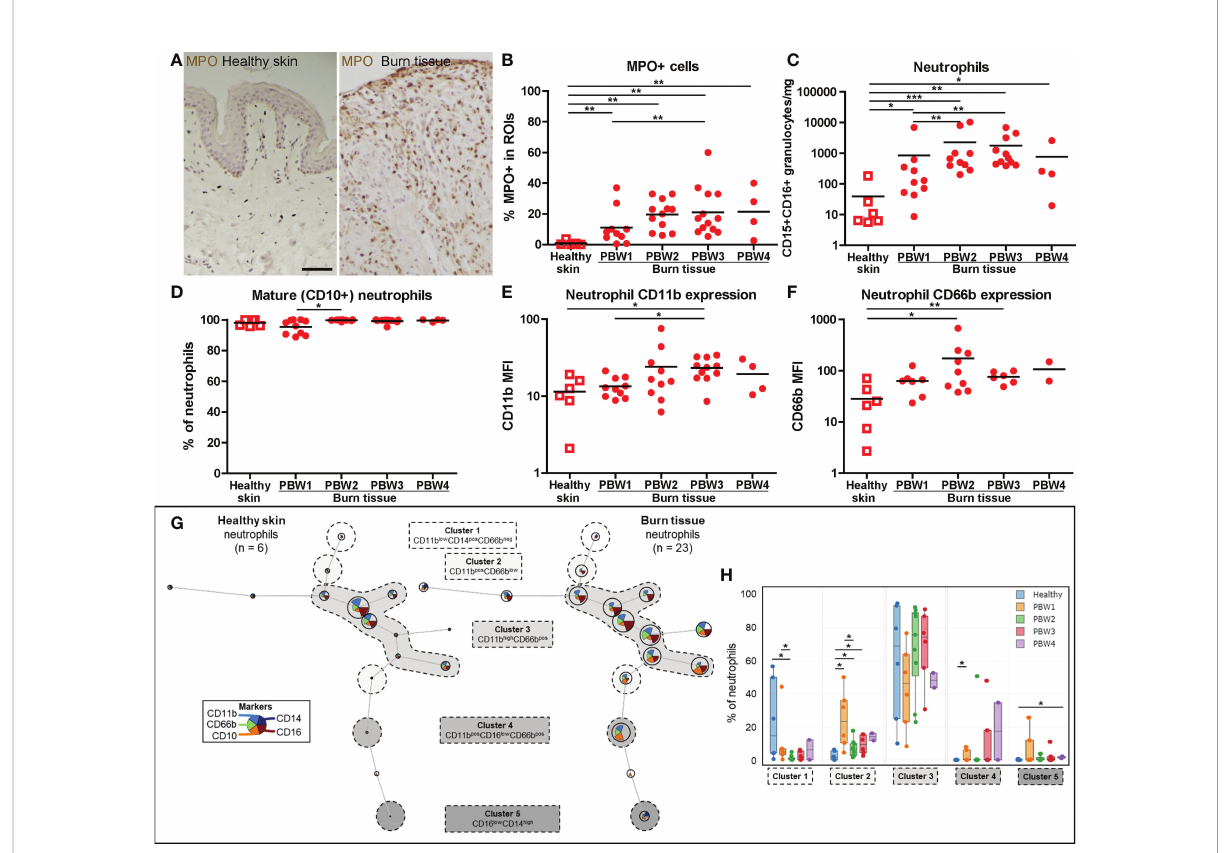
FIGURE 2 Local neutrophil response to burn injury. (A) Myeloperoxidase (MPO) immunohistochemical DAB staining of a representative section of healthy skin and burn tissue (from 15 days post burn) (black scale bar = 100 µm). (B) MPO + area of tissue sections. Flow cytometry-based quanti fi cation of: (C) Absolute number of neutrophils (CD15 + CD16 + granulocytes) per mg tissue; (D) Percentage of CD10 + (mature) neutrophils (CD15 + CD16 + granulocytes); (E) MFI of CD11b on neutrophils (CD15 + CD16 + granulocytes) in tissue; (F) MFI of CD66b on neutrophils (CD15 + CD16 + granulocytes) in tissue. (G) Unsupervised clustering of neutrophil (CD15 + CD16 + granulocytes) fl ow data from healthy skin and burn tissue, 5 clusters are highlighted. Node size represents relative size of population and node diagram shows expression level of markers. (H) Percentage of neutrophils within each cluster. Error bars in H show boxplot, p values were calculated using Mann-Whitney U statistical tests, signi fi cant differences are indicated by black asterisks: *p < 0.05; **p < 0.01; ***p <